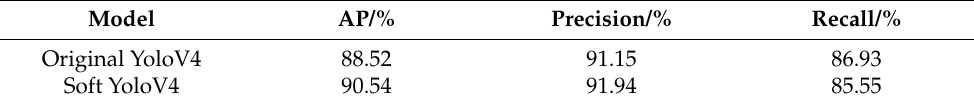
Table 1. The comparison results.